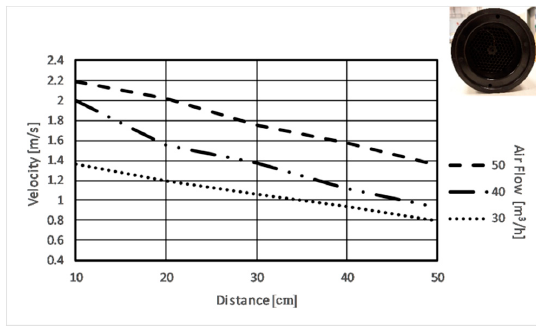
Figure 4. Mean air velocities in the case of the SAR circular perforated ATD.